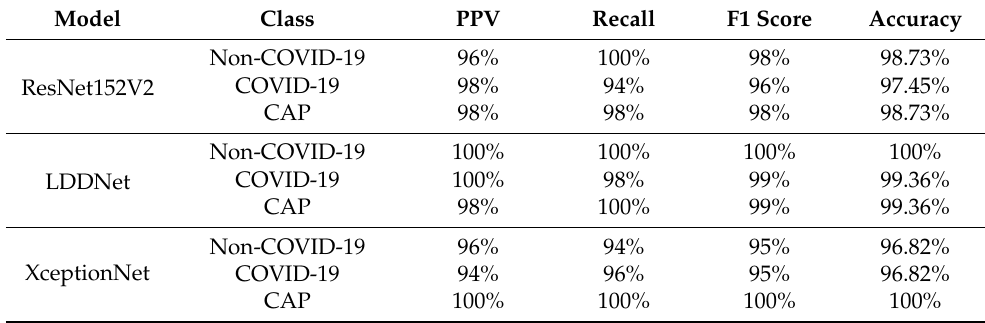
Table 6. Comparison of the different DL models for the Nadam optimizer.